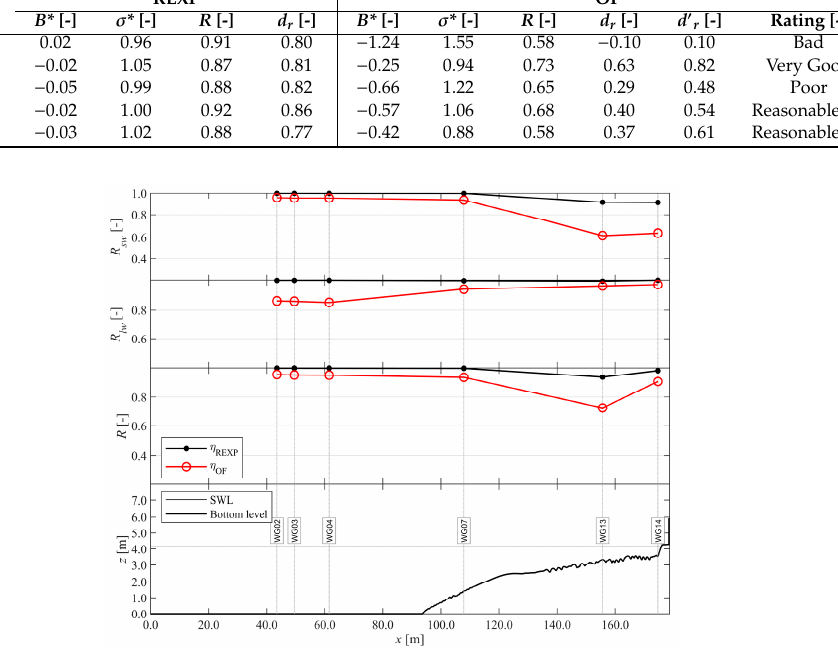
Table 4. Pattern and model performance statistics for all U x measurement locations on the promenade. Location